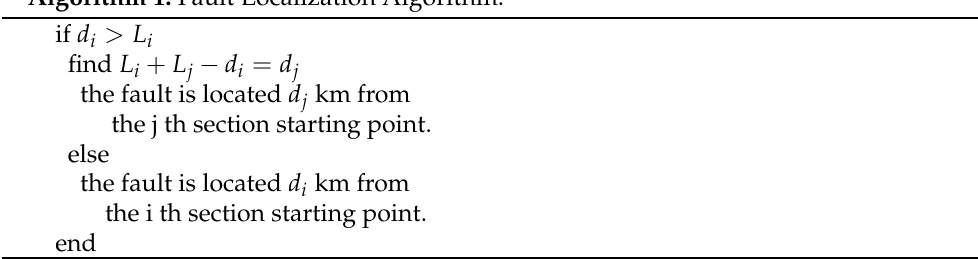
Algorithm 1: Fault Localization